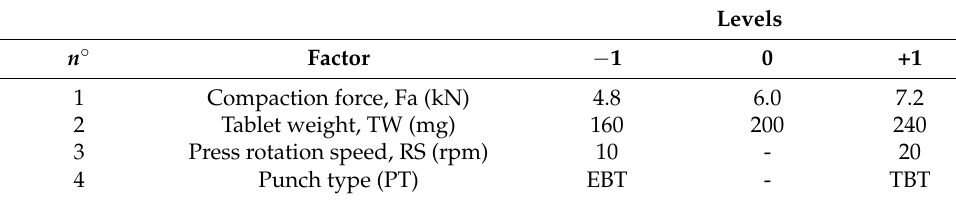
Table 2. Levels of DoE factors.